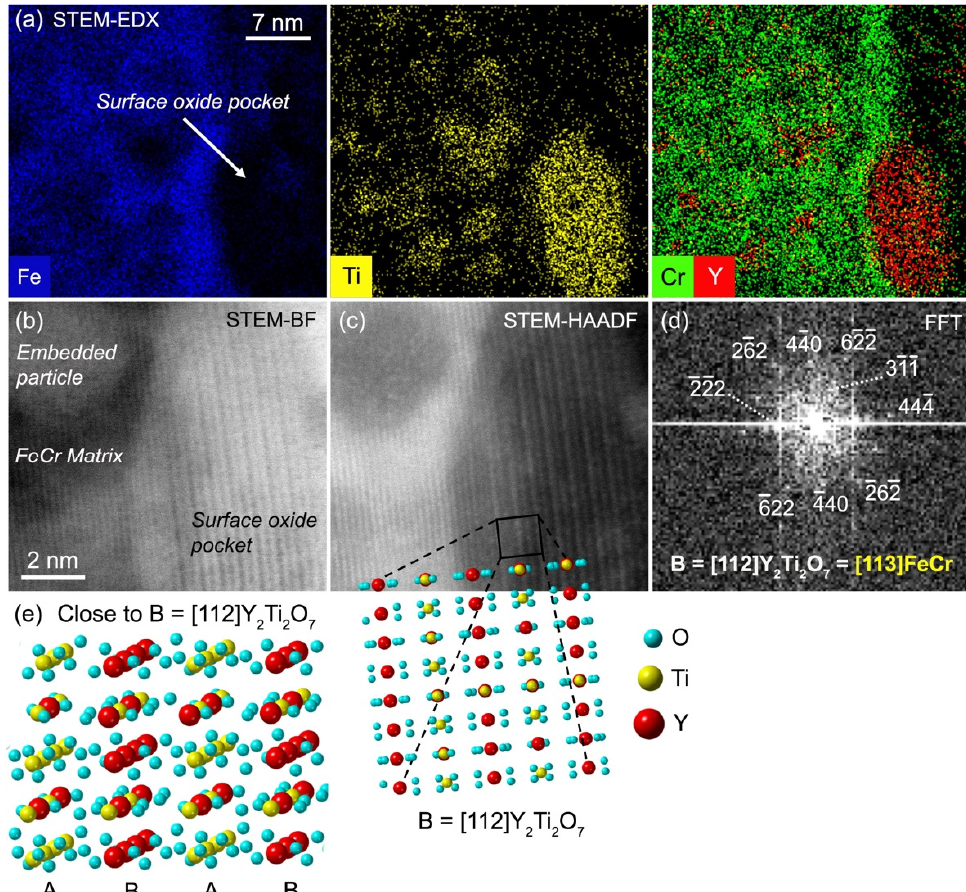
Figure 11. Analysis of an oxide pocket on the surface of an Y → Ti → O-implanted FeCr specimen after annealing at 1100 ◦ C: ( a ) compositional analysis with STEM-EDX; ( b ) STEM-BF image; ( c ) STEM-HAADF image; ( d ) FFT calculated on the surface oxide pocket from the STEM-HAADF image, along with results of crystallographic analysis; ( e ) periodic arrangements of atoms observed in Y 2 Ti 2 O 7 oriented along the zone axis B = [112]. Alternations of different (222) planes, labelled A and B, are